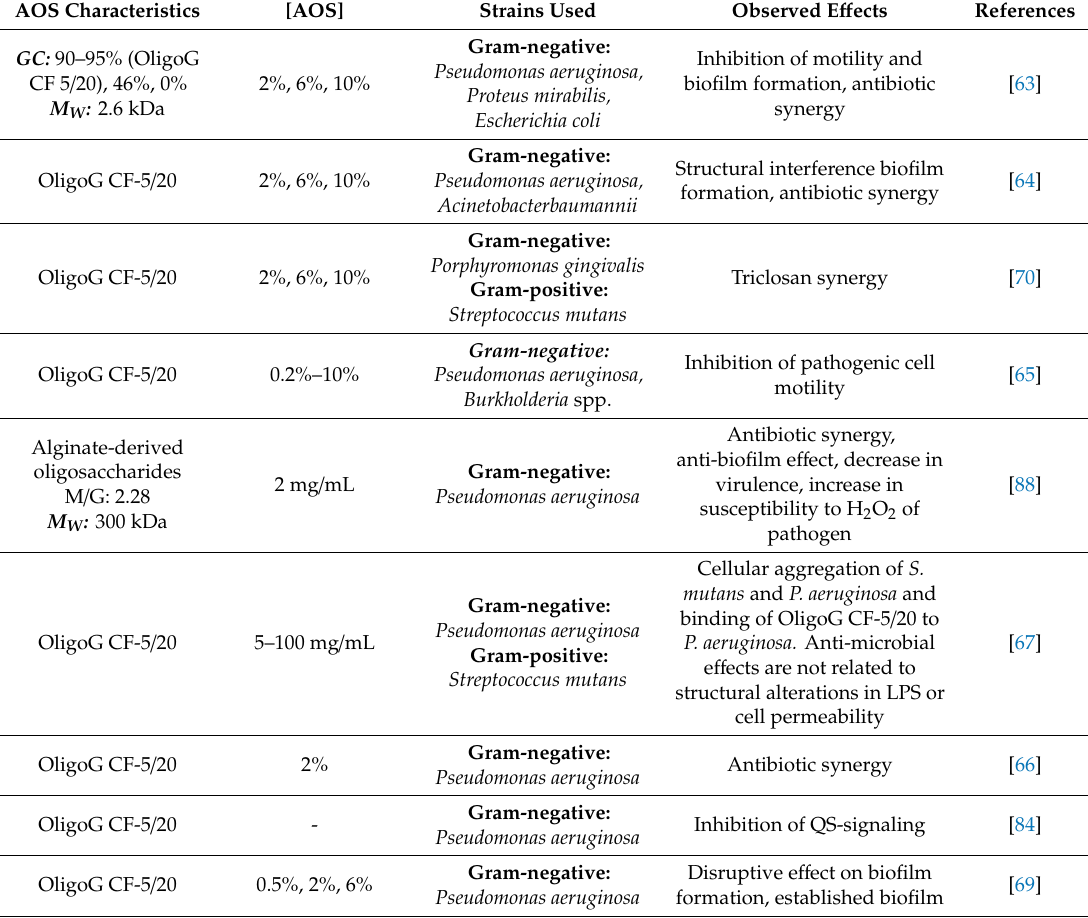
Table 3. Overview of the anti-pathogenic functionalities of